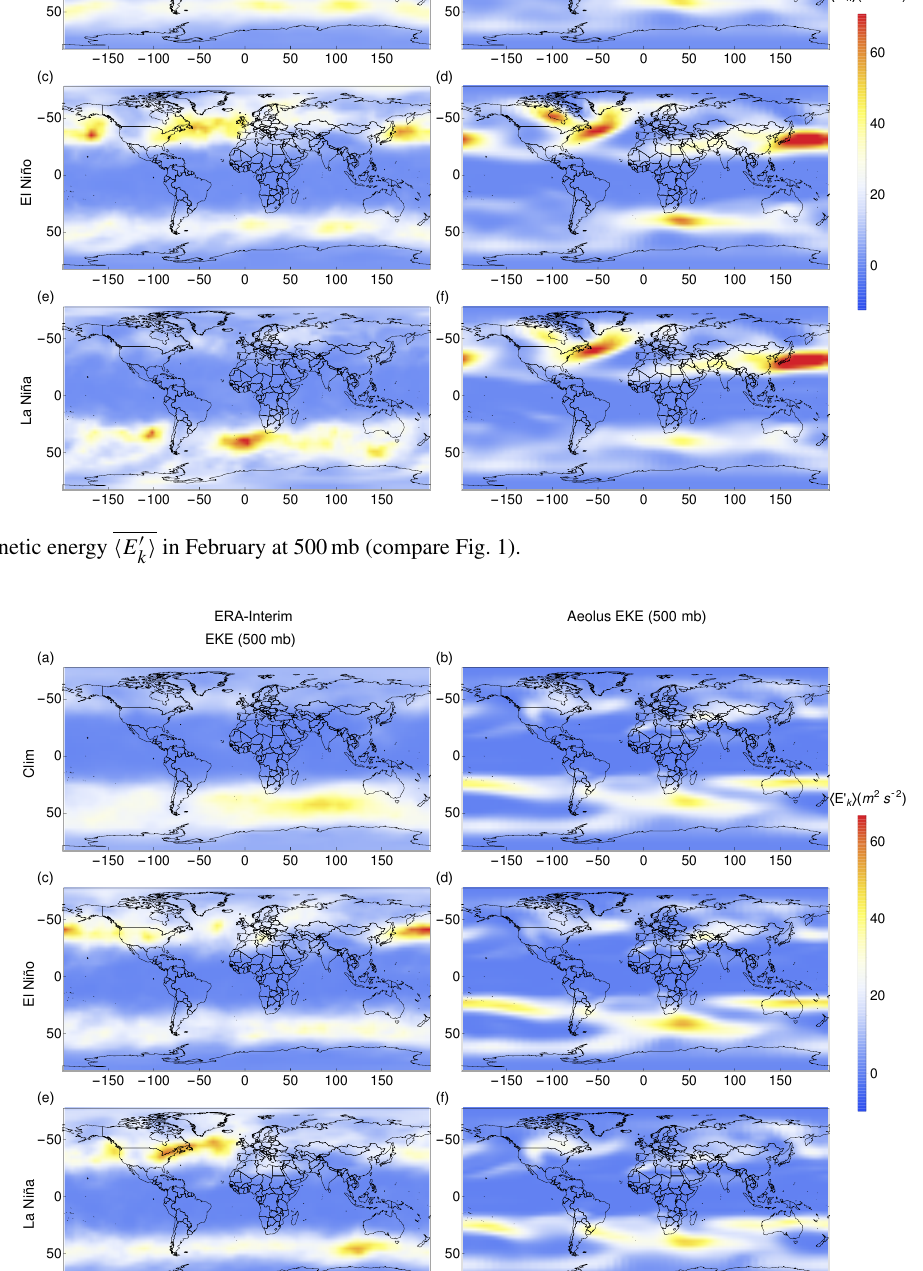
Figure 9. Eddy kinetic energy (cid:104) E (cid:48)